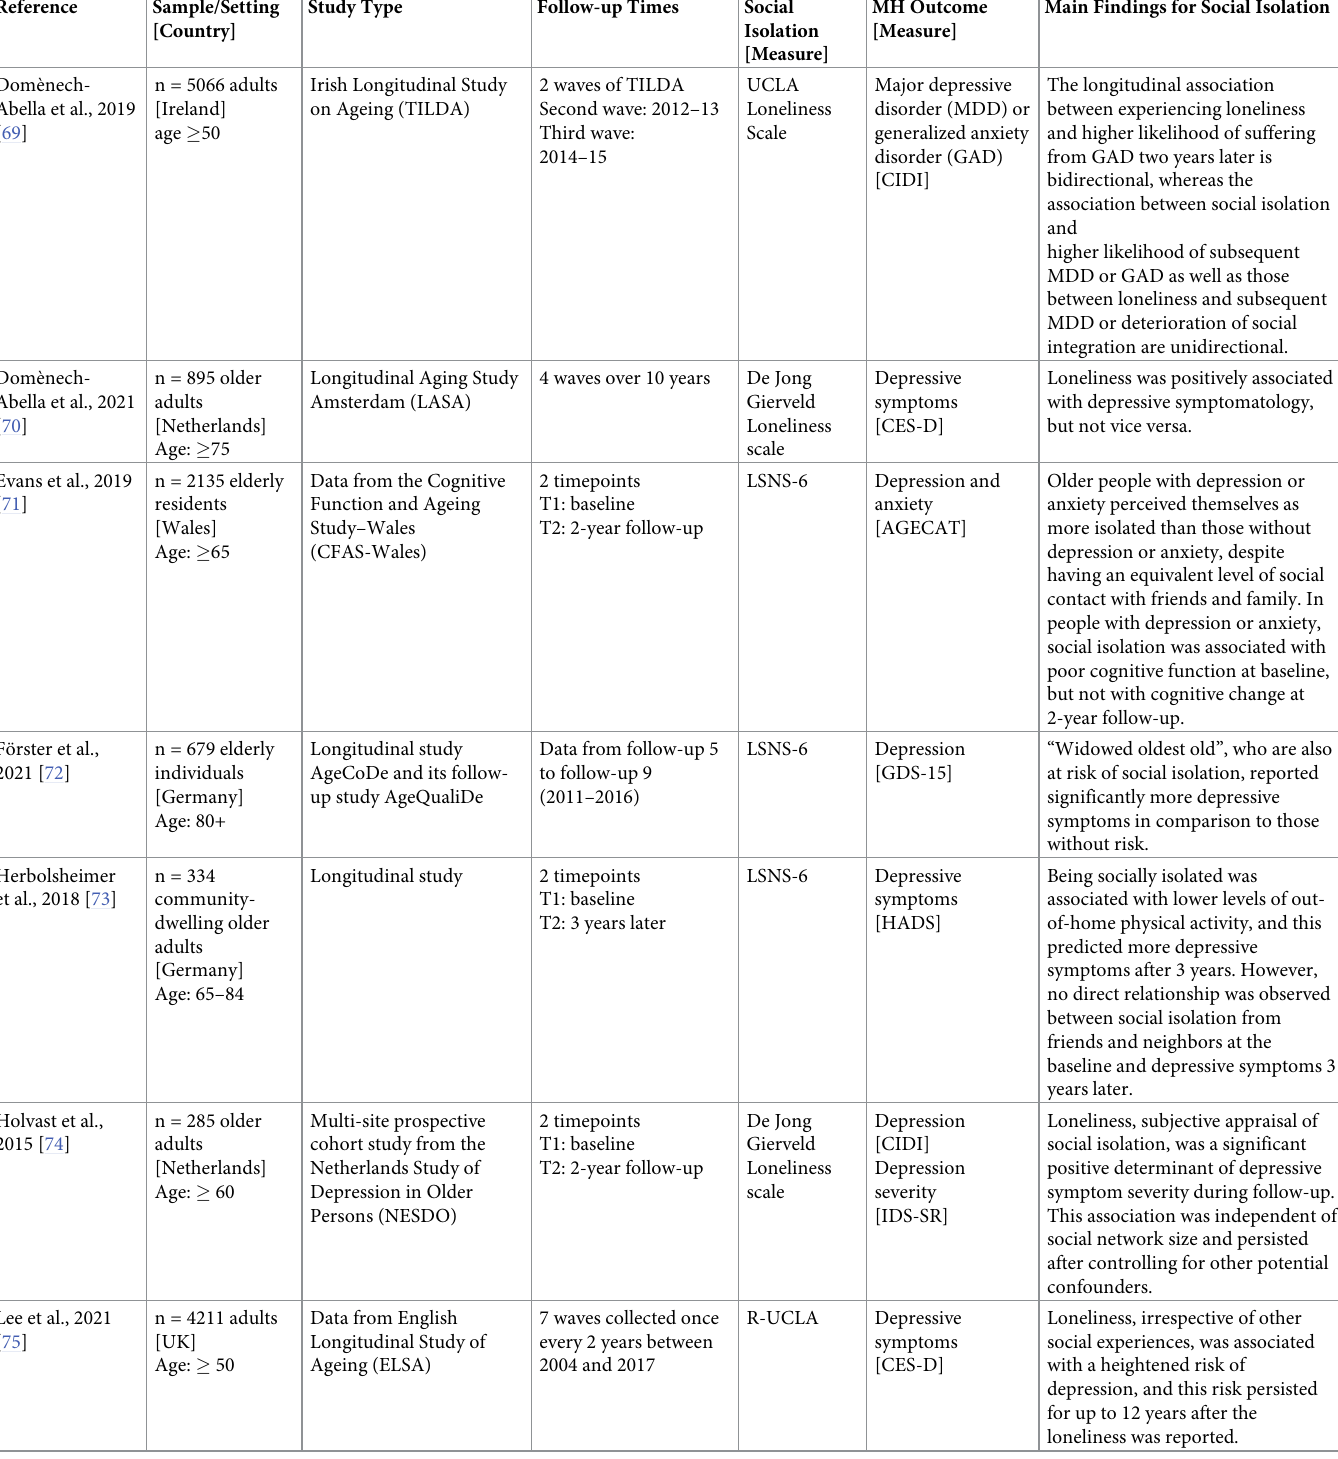
Table 2. Characteristics of included studies on social